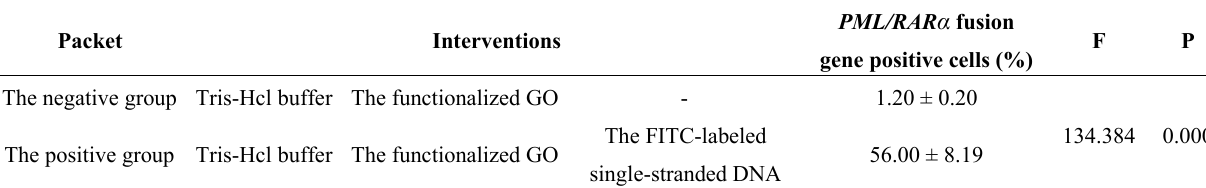
Table 2. The flow cytometry results of the positive and negative experimental NB4 group cells with the PML/RAR α fusion gene with and without intervention of the FITC-labeled single-stranded DNA